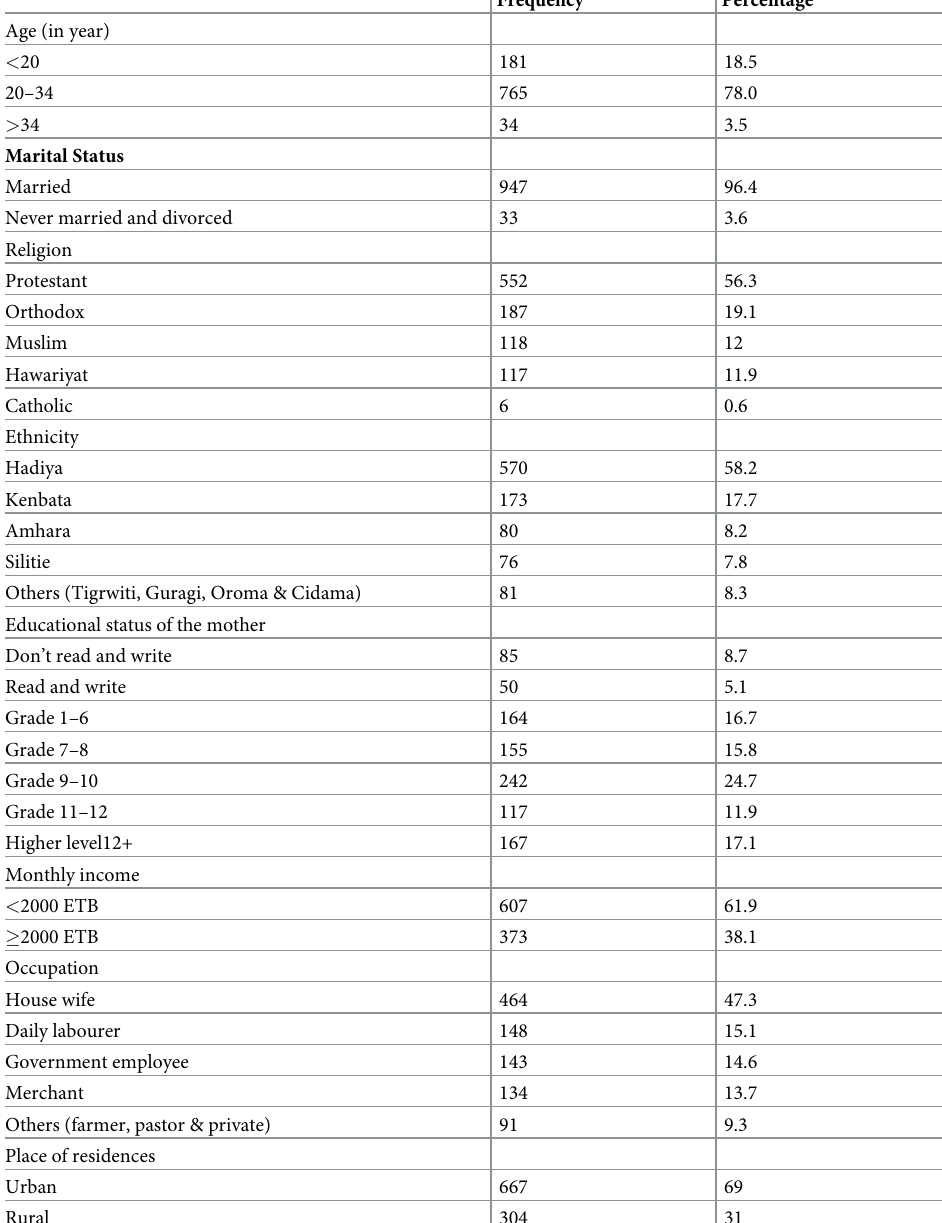
Table 1. Socio-demographic characteristics of the participant (n = 980) at Hossana town public health facilities, Southern Ethiopia July 2017 June